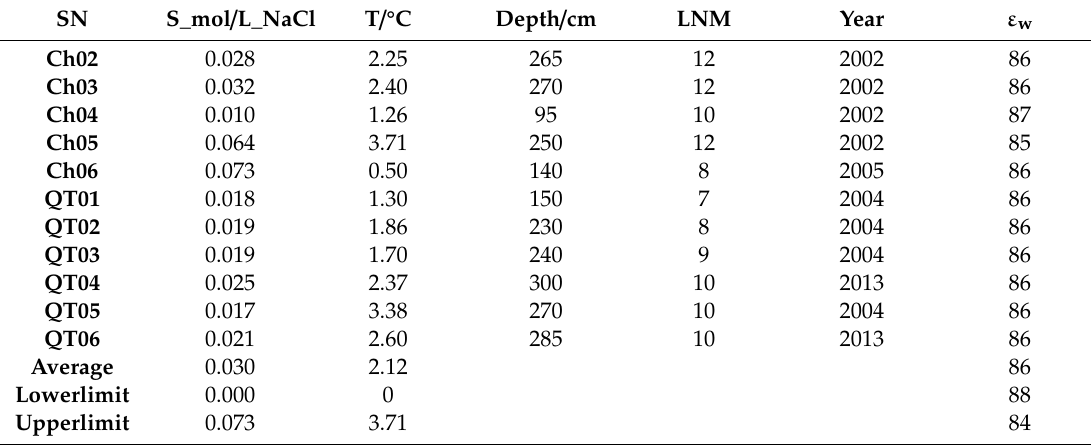
Table 2. The salinity and temperature variation range of active-layer soil water at the Qinghai–Tibet plateau and the calculated water dielectric constant ( ε w ) using Equation (7).